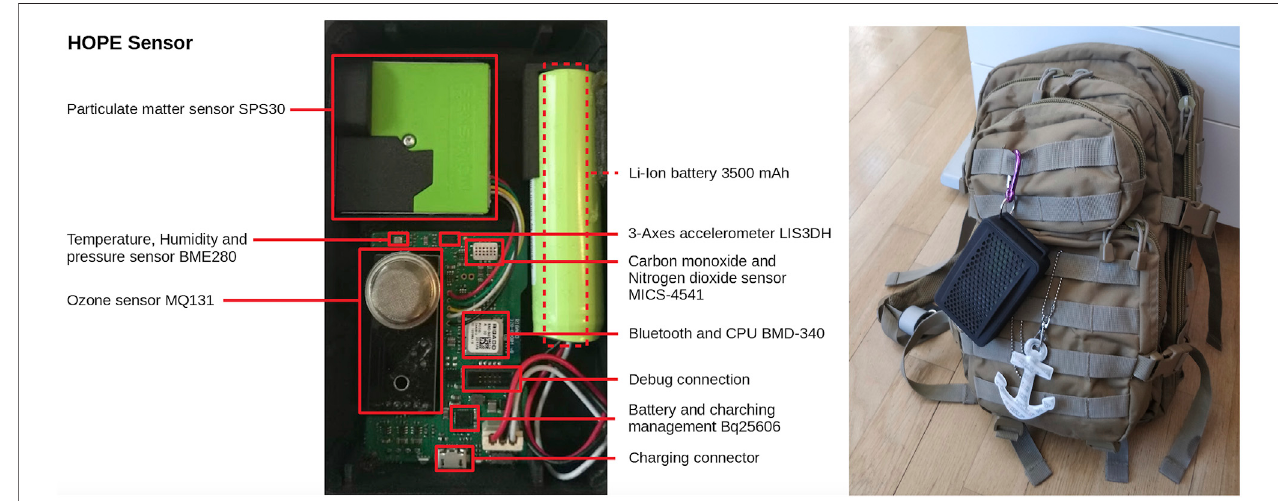
FIGURE 3 | HOPE sensor unit developed for participatory sensing of air quality attached to a backpack.